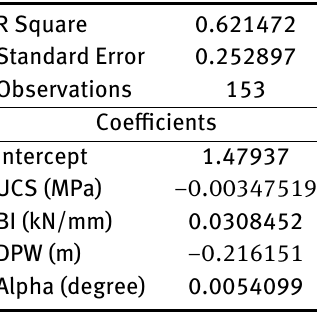
Table 3: Linear regression model.